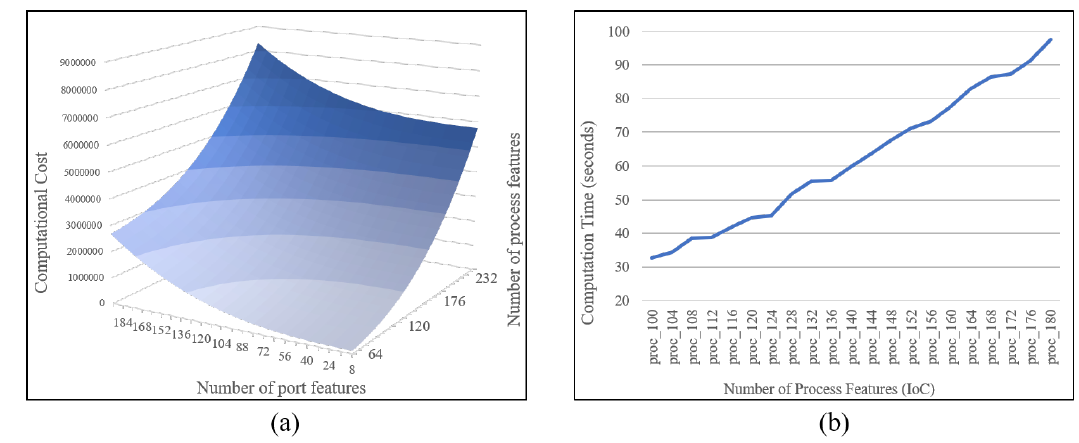
Figure 8. ( a ) Graph on the computational complexity ratio for two major features (number of processes, number of the port) that have the most significant impact on the complexity of the adjacent matrix. ( b ) Total data learning time for the number of processes of the node feature matrix X used in the